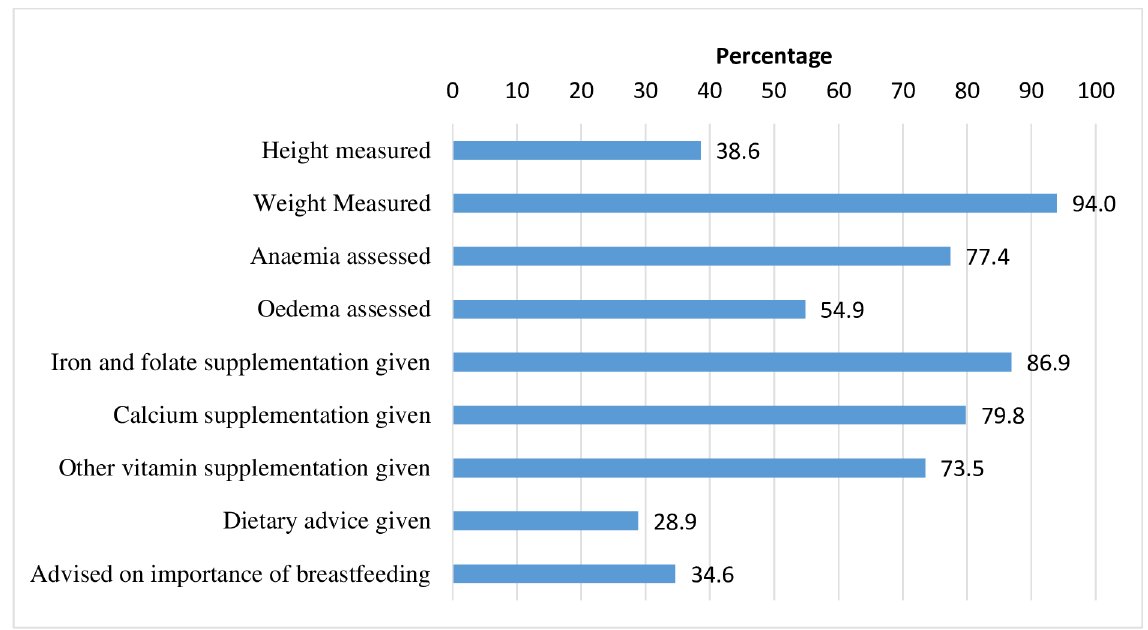
Fig 1. Proportion of women receiving different nutrition servicesas observed during serviceprovision of antenatal care (n = 381).